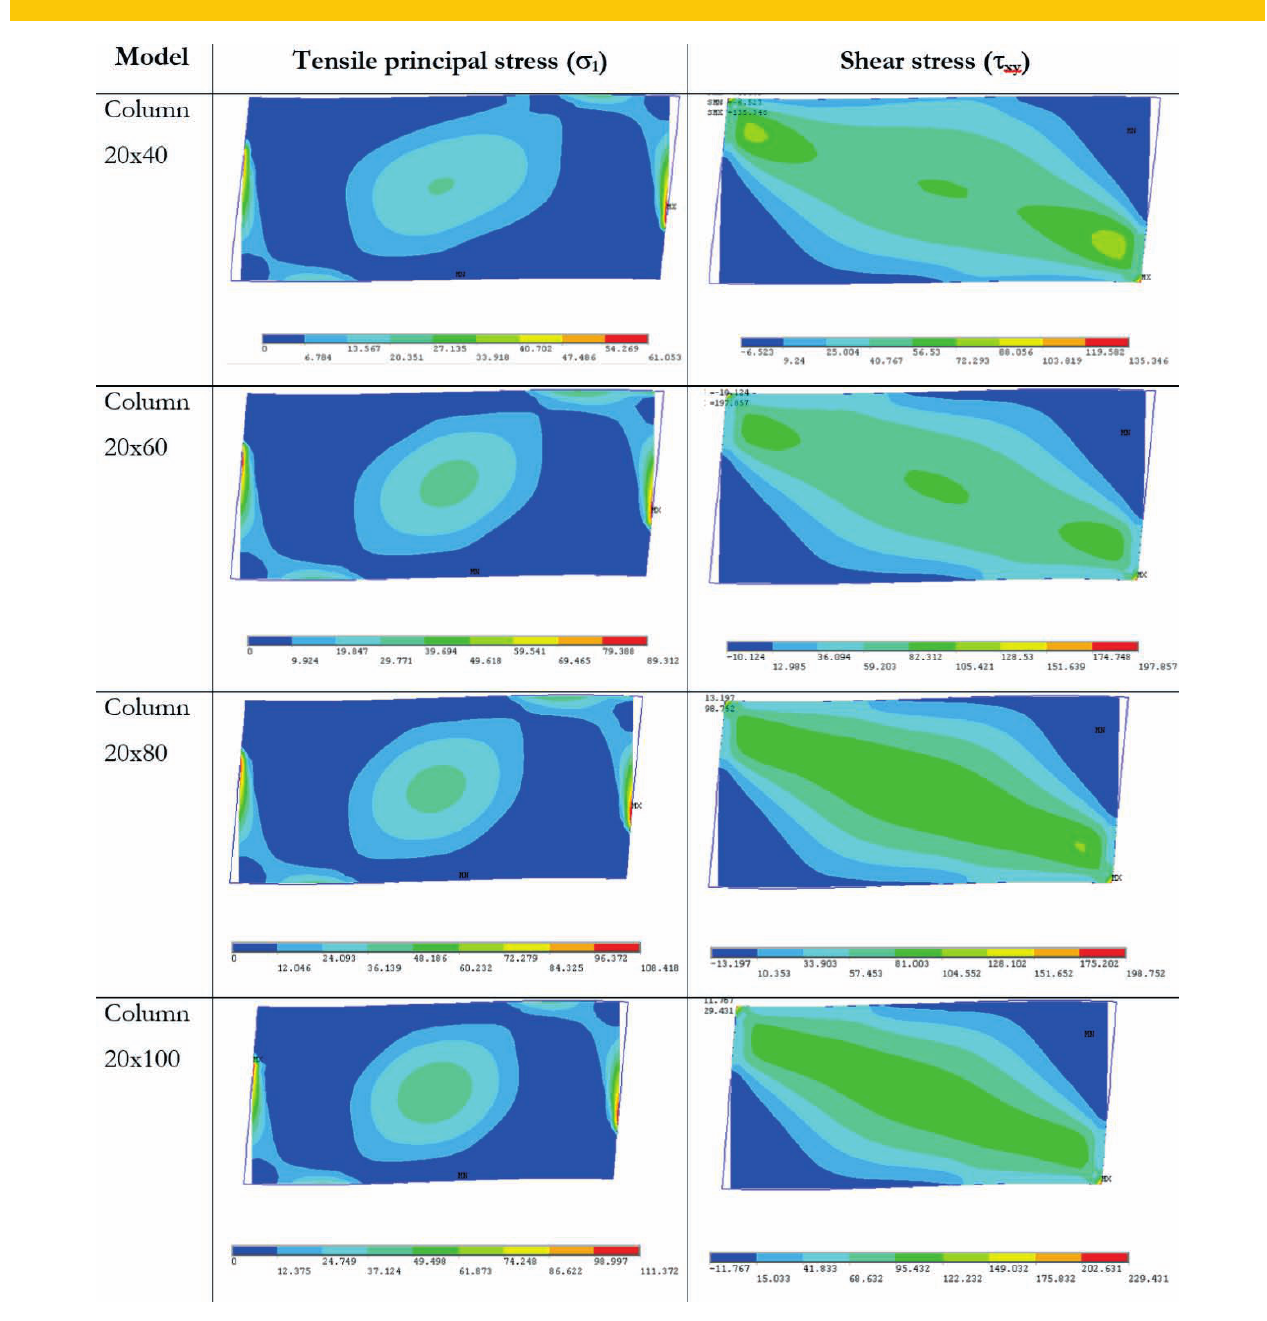
Figure 5 – Acting stresses related to diagonal tension and shear in infill walls – FEM models